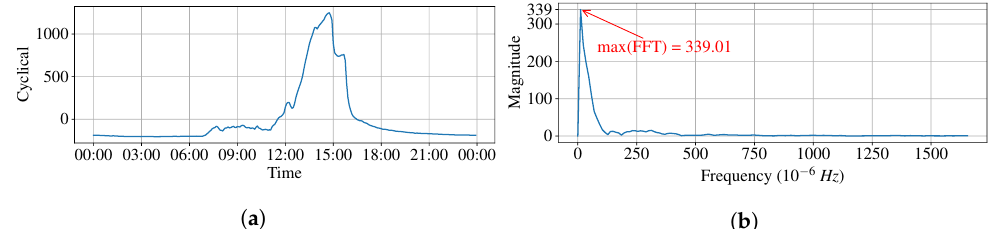
Figure 27. Week 6 of device D9365F CO 2 concentration cyclical component. ( a ) Time domain; ( b ) Frequency